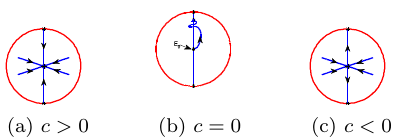
Figure 11. Infinite heteroclinic orbits of system (1.3) for c > 0 (left) and c < 0 (right) when b > 0. For c = 0 system (1.3) has singularly degenerate heteroclinic cycles (center). The boundary of the disks corresponds to the points at infinity in the plane y – z , see Figure 10.